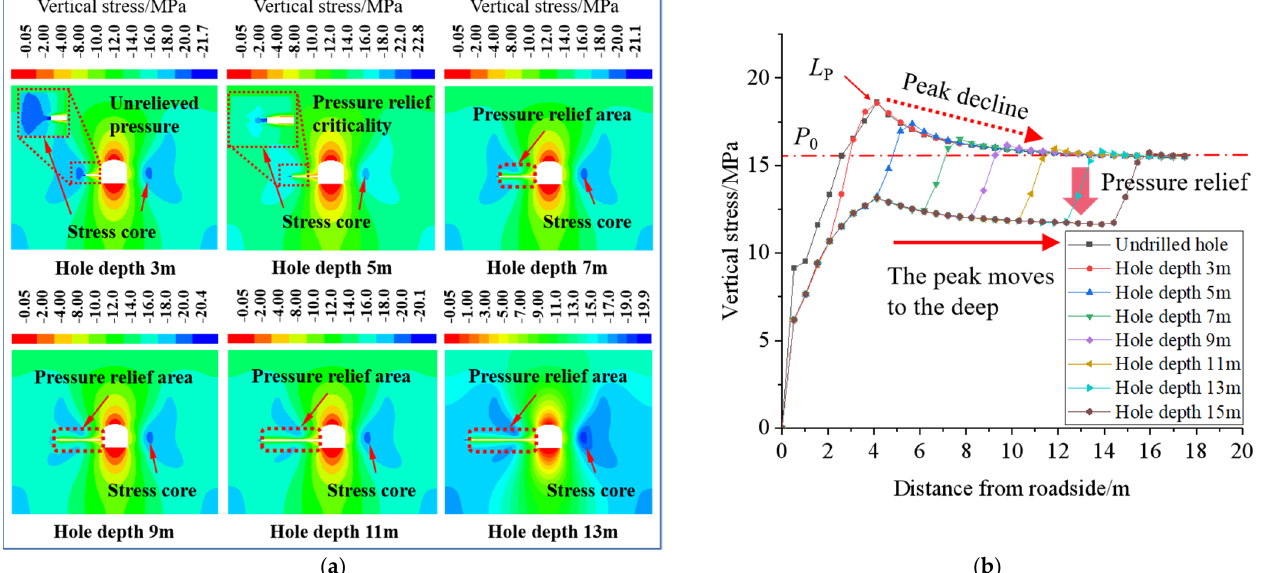
Figure 8. Pressure relief characteristics of the large − diameter borehole with different hole depths. ( a ) Evolution characteristics of the stress contour plot with different hole depths. ( b ) Evolution characteristics of the stress curves with different hole depths.